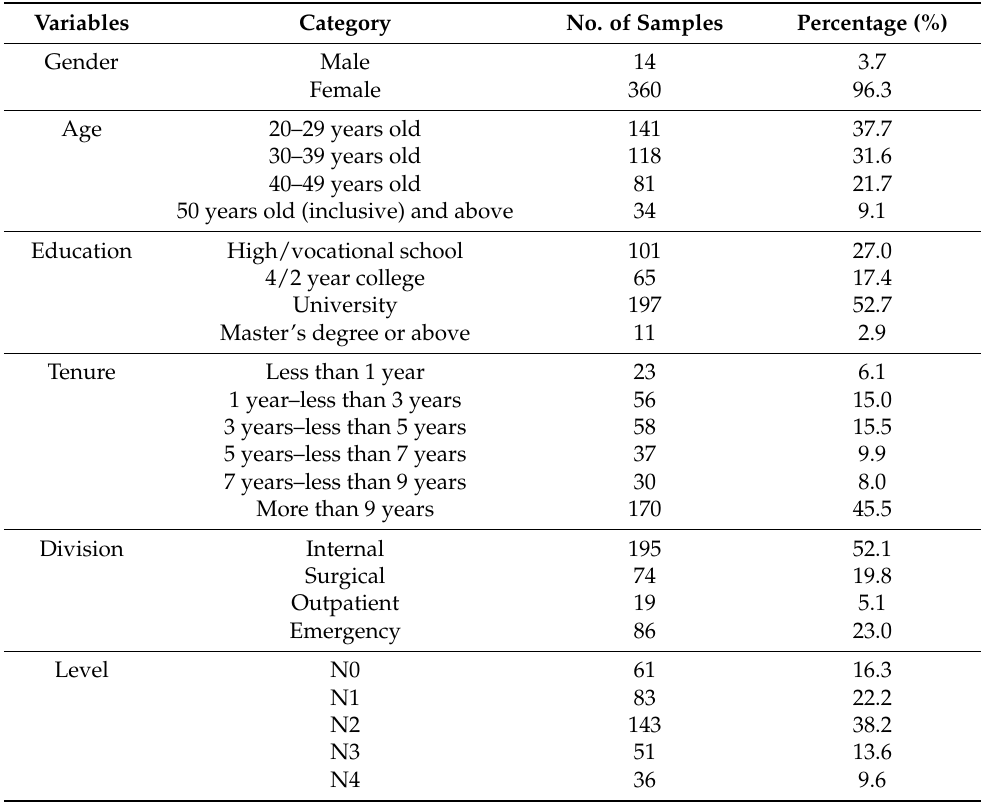
Table 2. Summary of the participant